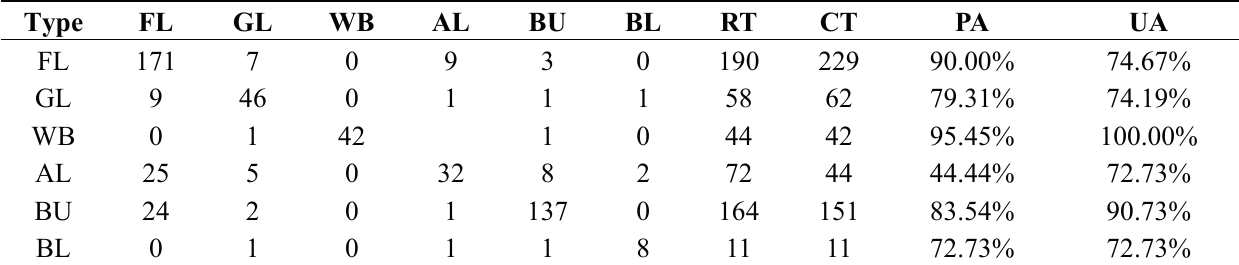
Table 3. Accuracy assessment for the 2010 classified images of Beijing,